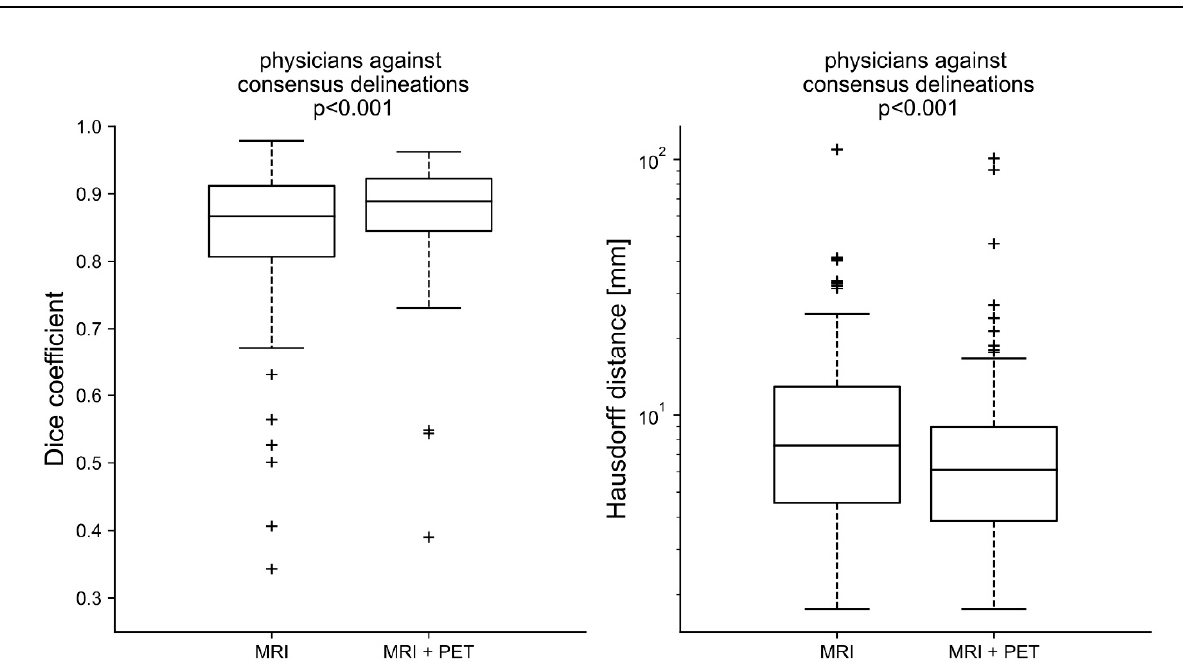
Figure 3. The Dice and Hausdorff coefficients were calculated for every delineation of a physician against the respective consensus delineation. The Dice coefficients for the MRI + PET modality were in closer proximity to each other and had fewer outliers (+) < 0.5, the differences in the delineations based solely on the MRI are significant ( p < 0.001). The Hausdorff coefficients were on average also smaller for the MRI + PET approach ( p <